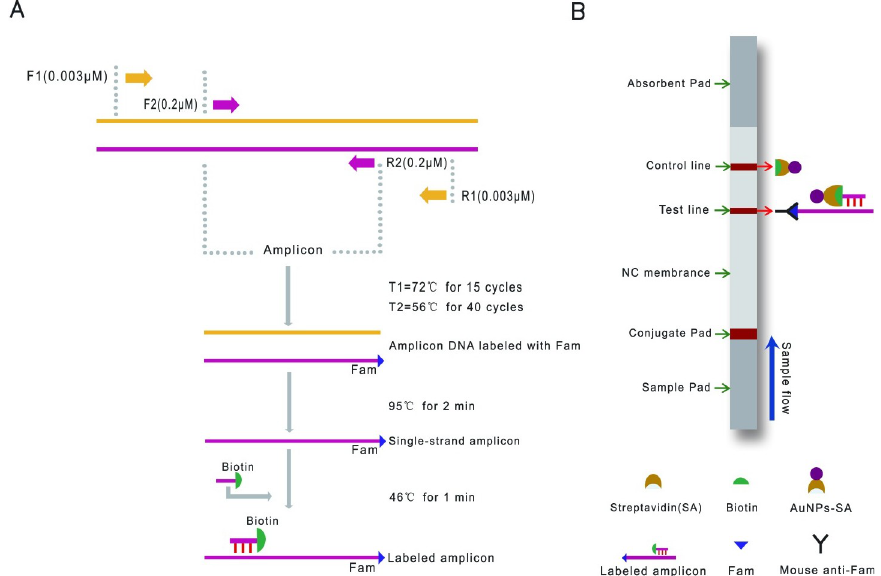
Fig 1. Schematic overview of the STNPCR-LFBA principle for detecting Alternaria panax Whetz. (A) Using the target DNA template, PCR amplification using the external primer pair (F 1 and R 1 ) will generate a PCR product that will be used for amplification by the inner primer pair (F 2 and R 2 ) in a single tube. The labeled single-stranded PCR product is hybridized with the labeled probe to form a nucleic acid hybridization complex (labeled with Biotin and Fam). (B) After placing the solution of the hybridization complex onto the sample pad of the biosensor, driven by the running stream, this complex is bound to a colloidal gold particle-streptavidin particles (AuNPs-SA) on the conjugate pad of the biosensor, followed by migrated further with the buffer stream, and the sample is trapped by the mouse anti- Fam antibody on the test line (T line) of the biosensor, the T line turns red. The excess unbound AuNPs-SA migrated and it can be captured by biotin on the control line (C line). The result is positive when both the T and C lines are red. The result is negative if only the C line is